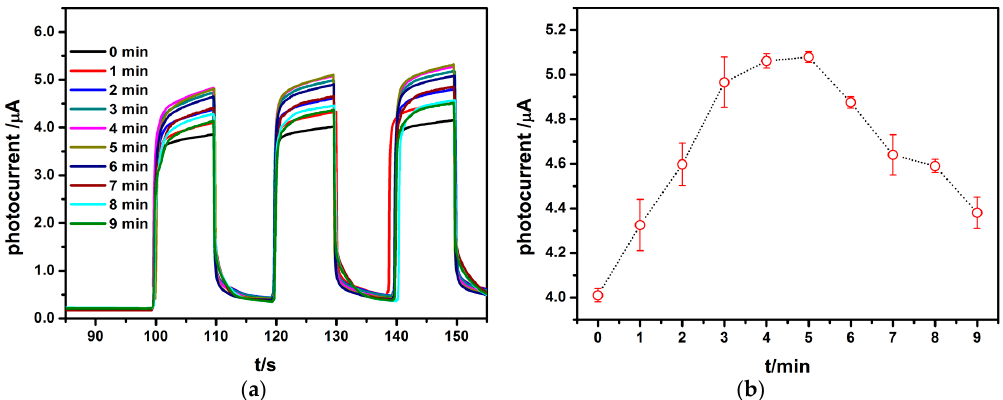
Figure 3. Photocurrent responses of TiO 2 NTs/Au nanoparticles (AuNPs) after different deposition time (0, 1, 2, 3, 4, 5, 6, 7, 8, 9 min): ( a ) the photocurrent curves of the TiO 2 NTs deposited for different times in 0.1 mM HAuCl 4 ·4H 2 O under deposition potential 0 V; ( b ) peak currents of the TiO 2 NTs for different deposition times ( N = 3).